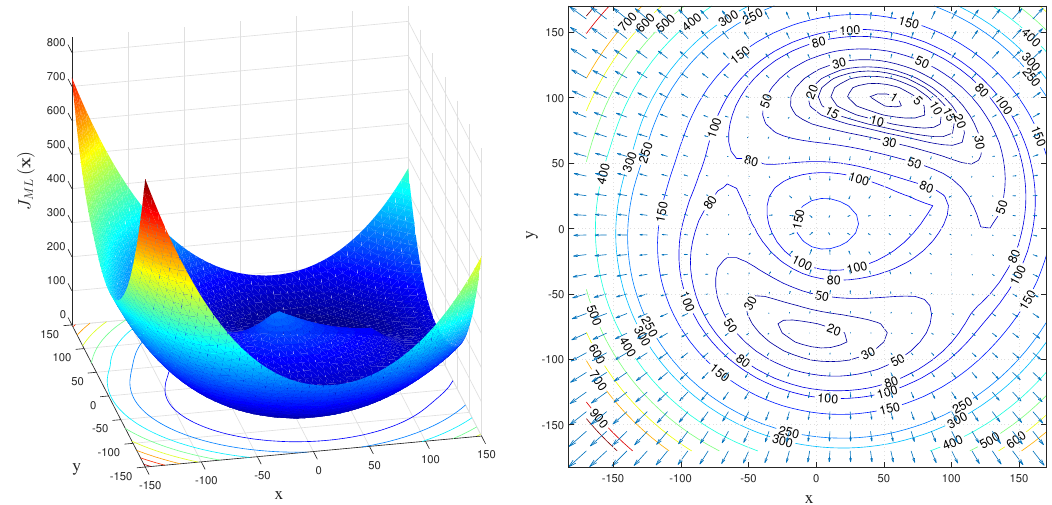
Figure 2. The plot of the considered ML objective function J ML ( x )